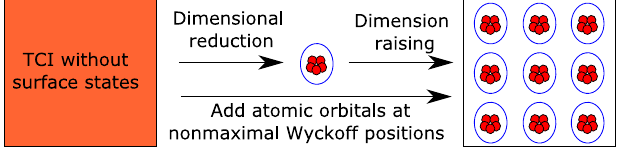
FIG. 15. Schematic illustration of the proof that all TCIs without surface states admit a Wannier representation possible after the addition of some atomic d.o.f. Using the layer construction, we show in the main text that any d -dimensional TCI without surface states protected by point group symmetries can be mapped to a Wannier representable phase by first using the dimensional reduction to a 0D atomic insulator then using the dimensional raising or layering procedure. The mapping involves the addition of some atomic orbitals at nonmaximal Wyckoff